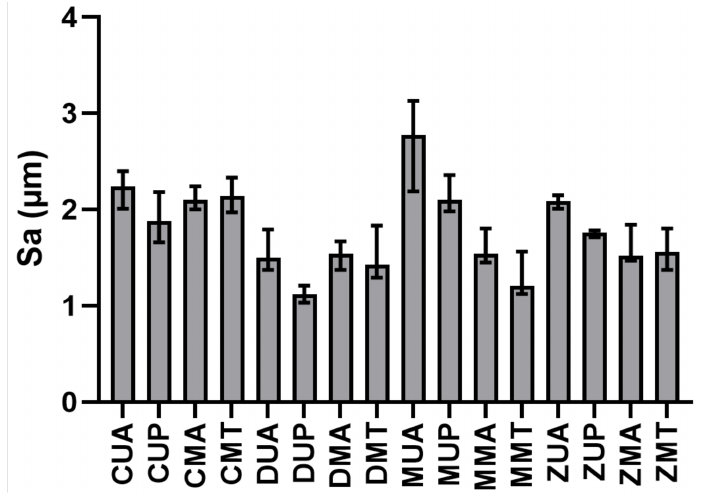
Figure 22. Median and extreme values of Sa for each combination. The material (C: composite, D: lithium disilicate, M: metal ceramic, Z: zirconium ceramic) and instrumentation (UA: ultrasonic- steel, UP: ultrasonic-peek, MA: manual-steel, MT: manual-titanium) are indicated along the abscissa